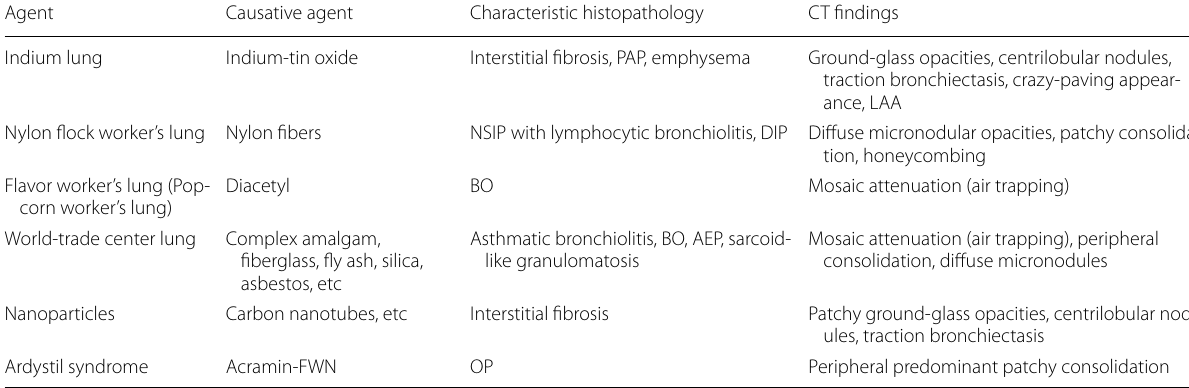
PAP, pulmonary alveolar proteinosis; NSIP, nonspecific interstitial pneumonia; DIP, desquamative interstitial pneumonia; BO, bronchiolitis obliterans; AEP, acute eosinophilic pneumonia; OP, organizing